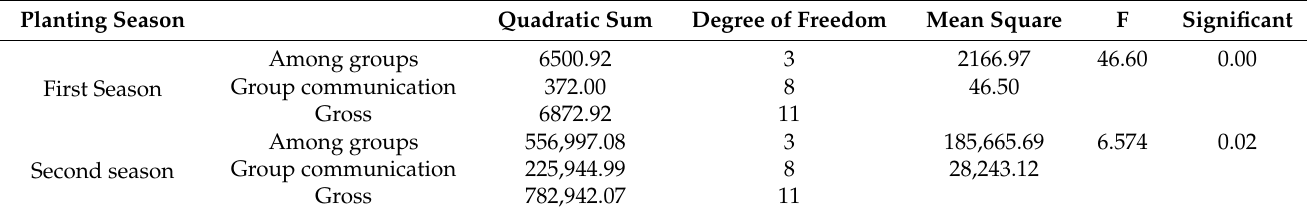
Table 3. Analysis of univariate variance for different water